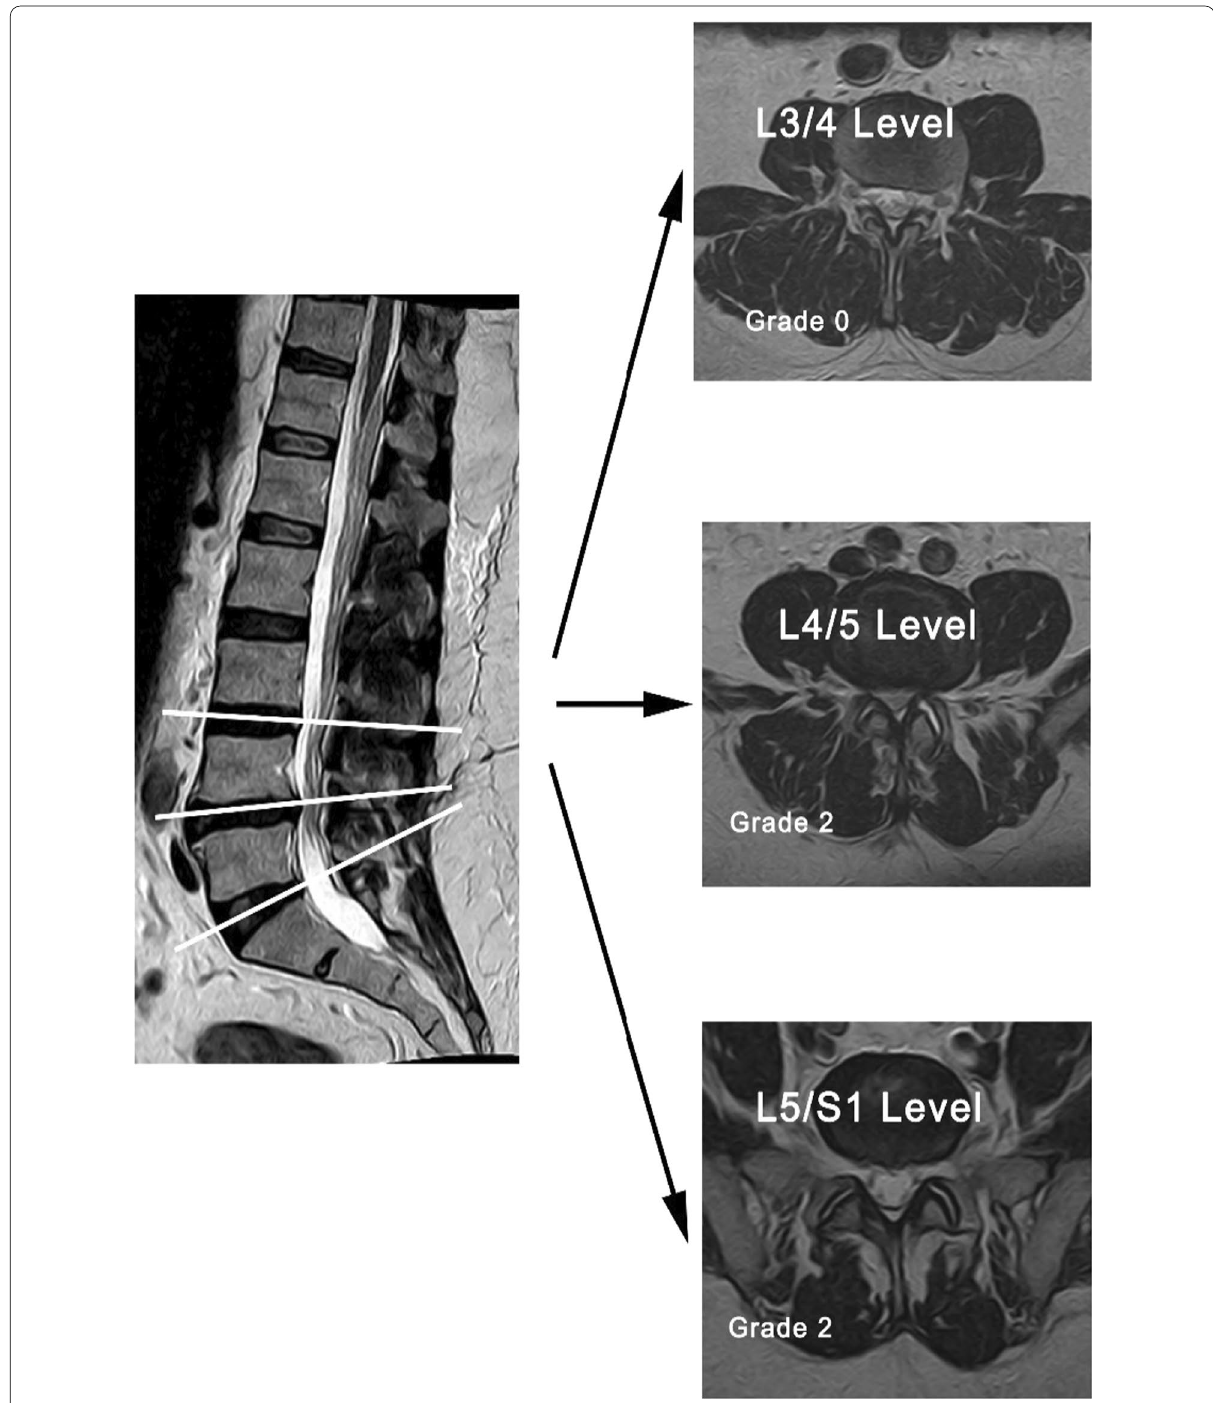
Fig. 2 Lumbosacral MRI, of a 57-year-old man with 5 years history of LBP without sciatica, BMI neural canal stenosis. Average VAS score 5. Axial cuts revealed grade 0 MS degeneration at L3/4 level, grade 2 MS degeneration at L4/5 and L5/ = S1 levels, MS 4. MS 1.154 (0.017*Age) (0.184* duration years) = = + + MS =